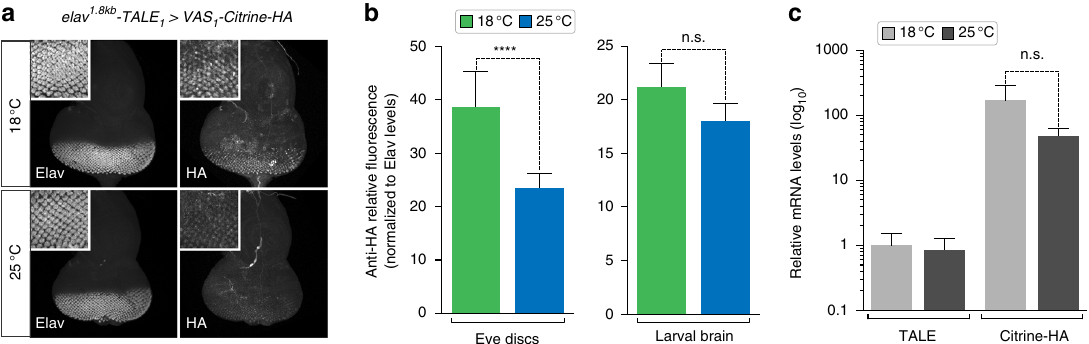
Fig. 3 Impact of temperature on TALE – VAS activity. a Eye discs from elav 1.8kb - TALE 1 > VAS 1 - Citrine-HA larvae stained with anti-Elav and anti-HA (transgene expression) antibodies reared at 18 and 25 °C. Insets show detail of the retina used to quantify fl uorescence levels. Scale bar = 100 µ m. b Quanti fi cation of Citrine-HA protein levels (anti-HA fl uorescence normalised to anti-Elav levels) in eye discs and larval brains at 18 °C ( n = 11 discs; n = 3 brains) and 25 °C ( n = 10 discs; n = 4 brains; mean ± s.d. unpaired t -test n.s. P > 0.05, **** P < 0.0001). c RT-qPCR quanti fi cation of TALE 1 and Citrine-HA mRNA expression from dissected third larval instar brains at 18 and 25 °C ( n = 3 biological replicates, 10 brains each; mean ± s.d. unpaired t -test n.s. P